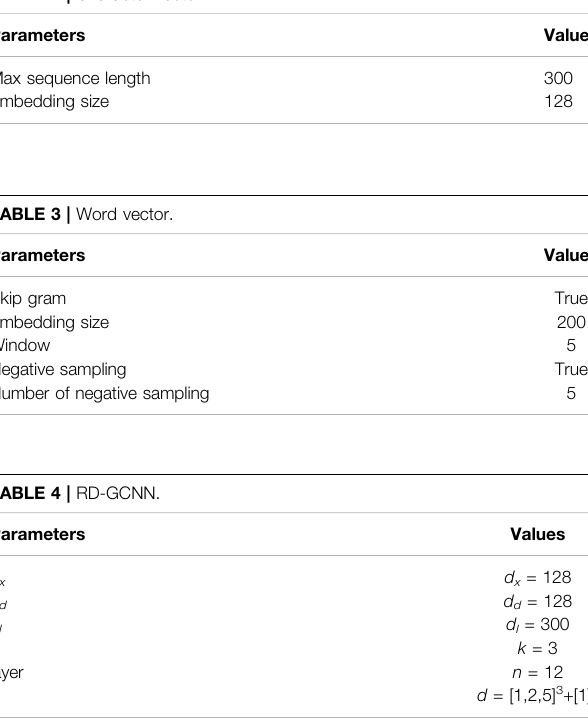
TABLE 5 | Multi-head